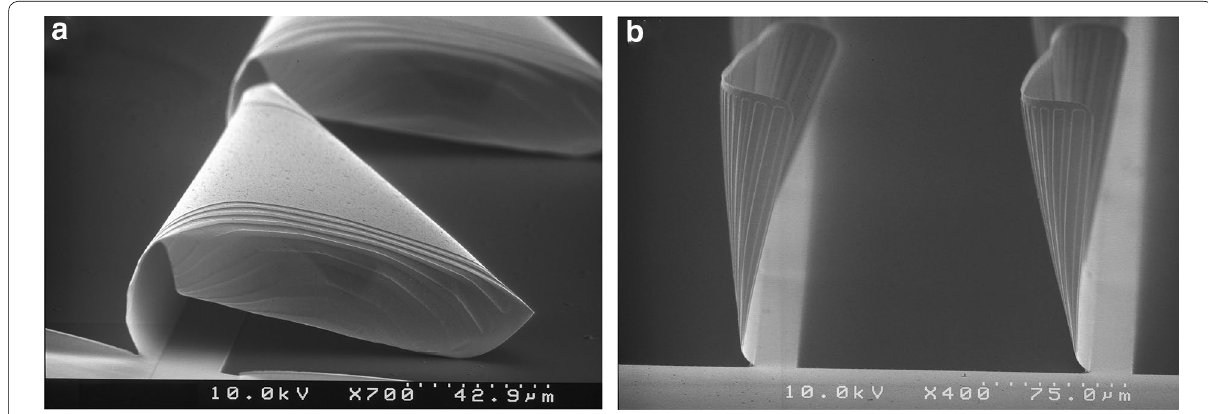
Fig. 4 SEM images of micromirrors containing sub-structures with design I ( a ) and design II ( b